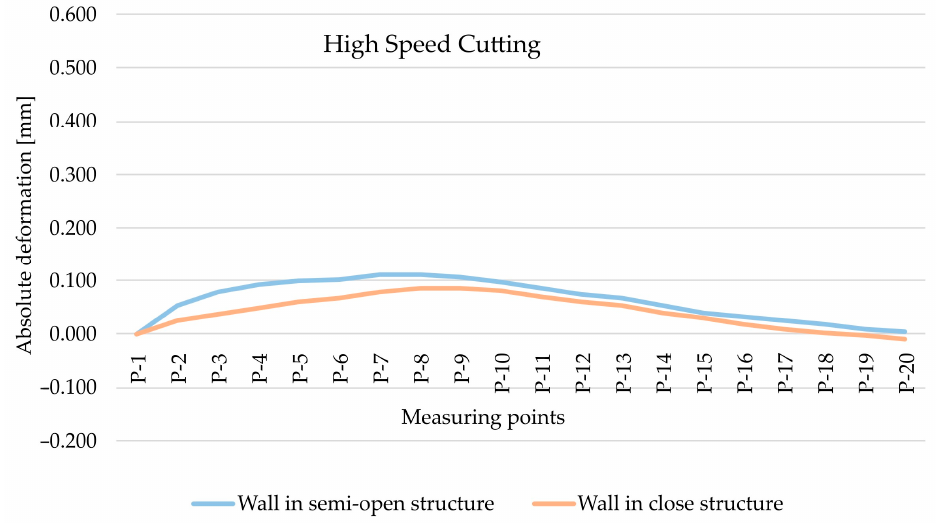
Figure 12. The comparison of absolute deformation for individual measurement points depending on the geometry of the thin-walled sample for HSC and for the EN AW-6082 T651 aluminium alloy. As regards the EN AW-6082 T651 alloy, the cutting method was also analysed.